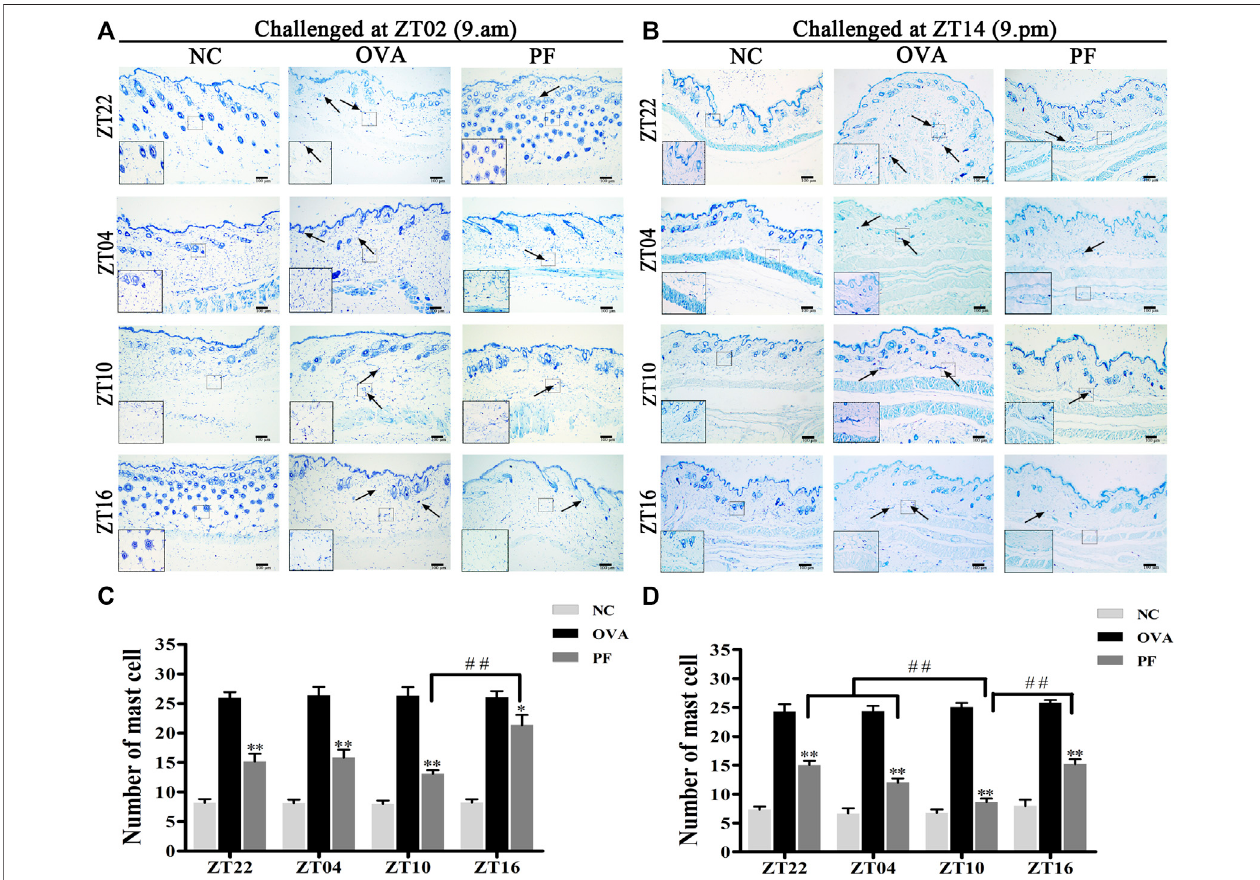
FIGURE4| Representative low-magni fi cation lightphotomicrographs (A,B) ,and numbers (C,D) displayingtoluidine blue stainingofmastcell degranulation (black arrows). The mast cell degranulation increased with OVA/aluminium hydroxide administration. Oral administration of PF resulted in a signi fi cant reduction in mast cell degranulation. Data are expressed as mean ± SEM ( n (cid:1) 6). *p < 0.05, ** p < 0.01 versus OVA mice at the same time points. ## p < 0.01 represents the comparison of PF ZT10 versus the other three PF groups. The magni fi cation were × 100 and 400 ×